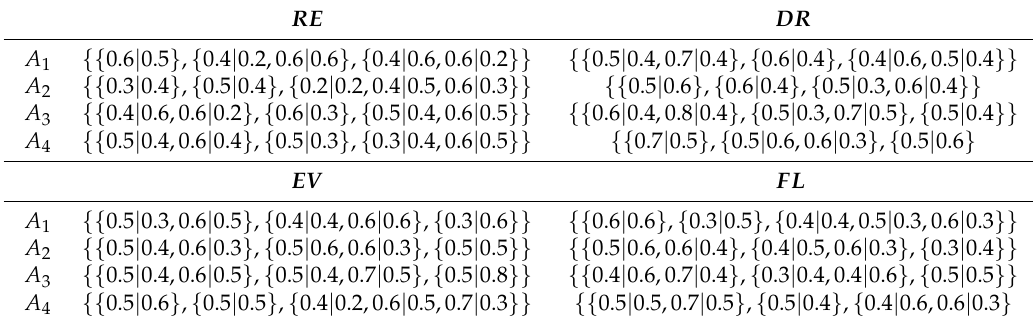
Table 5. Probabilistic neutrosophic hesitant fuzzy decision matrix of E 2